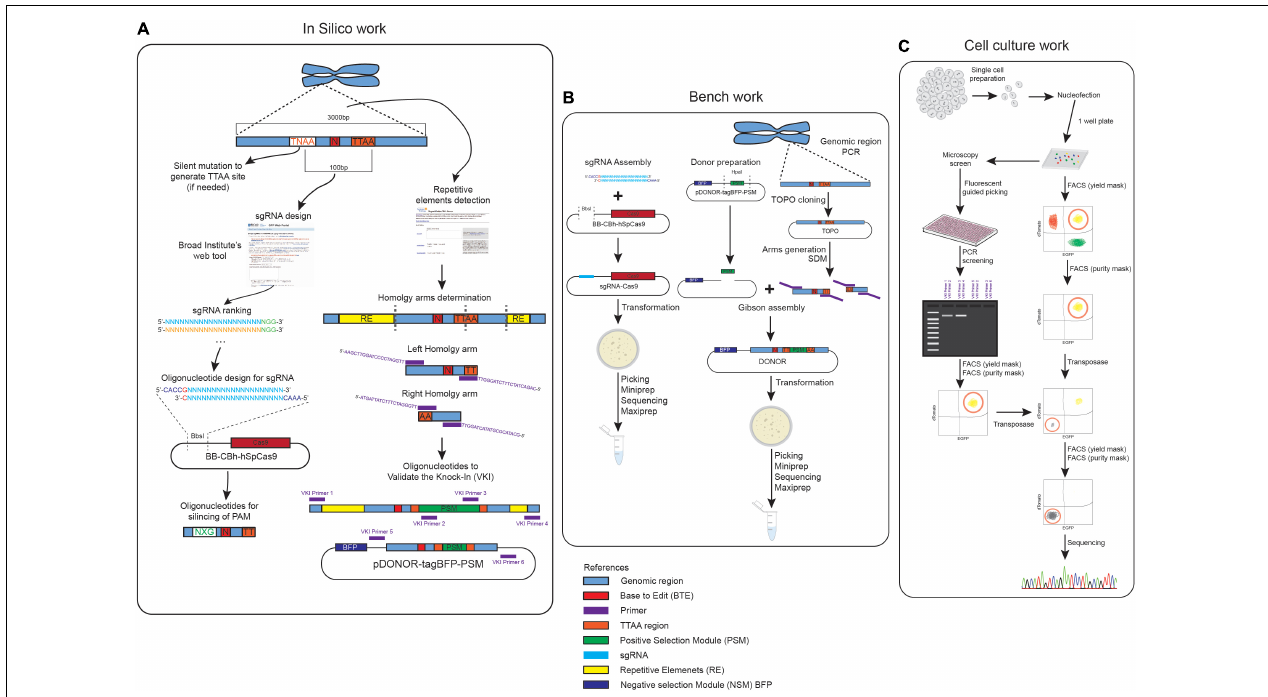
FIGURE 1 | Graphical summary of the pipeline of work. (A) Summary of the different steps of in silico work designing the donors, the sgRNA and the oligonucleotides used to generate the constructs. (B) Graphical summary of the different steps involved in the generation of the donor and sgRNA construct. (C) Different paths of the knock-in and removal of the construct based on a fluorescent guided picking or FACS panclone generation approach.